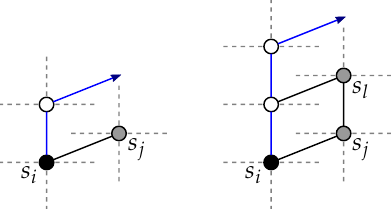
Figure 4. A vertex of ( S ∪ D ) \ { s i , d i } can block at most one of the disjoint candidate paths for a vertex s i (selected paths in blue)